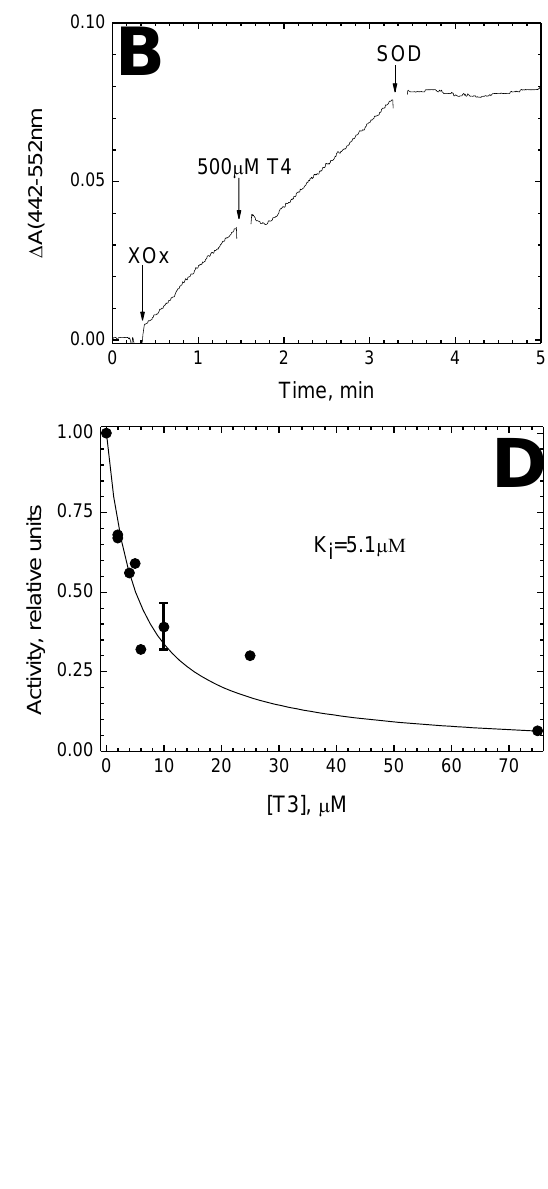
13 of 23 Figure 6. Effect of T4 on the formation of CcO oxoferryl intermediates during the reaction with H 2 O 2 . The reaction was followed using a diode array spectrophotometer. Final concentrations after mix- ing: 3.25 μM CcO, 1 mM H 2 O 2 , 0.5 mM T4. ( A , B ) Kinetics of the oxoferryl intermediates ’ formation. Spectral forms F I -607 (trace 1 , black) and F II -580 (trace 2 , red) are followed by the absorption differ- ences at 606 – 700 nm and 571 – 501 nm, respectively. ( A ) Control; ( B ) CcO was pre-incubated with 0.5 mM T4 until mixing. ( C ) Difference spectra (15 s vs . 0.2 s after mixing) obtained in the absence (con- trol spectrum 1 , black) and presence (spectrum 2 , red) of 0.5 mM T4. Panels ( A ) (control) and ( B ) (experiment in the presence of T4) show kinetic traces of F I -607 and F II -580 formation. In the presence of T4, F I -607 forms slightly slower (t 1/2 ≈ 0.99 s vs. 0.91 s) and its yield is lower than in the control ( cf. black curve 1 in panels ( A , B )), whereas the formation of F II -580 is accelerated by 23% (t 1/2 ≈ 0.85 s vs. 1.1 s) and the yield is higher than in the control ( cf. red curve 2 in panels ( A , B )). Figure 6C shows the differ- ence absorption spectra of the control sample (spectrum 1 ) and the sample treated with T4 (spectrum 2 ) obtained 15 s after mixing, when the observed difference looks most valid. As seen, in the presence of T4, the concentration of F I -607 is lower and F II -580 higher than in the control, though the deviation is only about 10%. Accordingly, the overall decrease of the